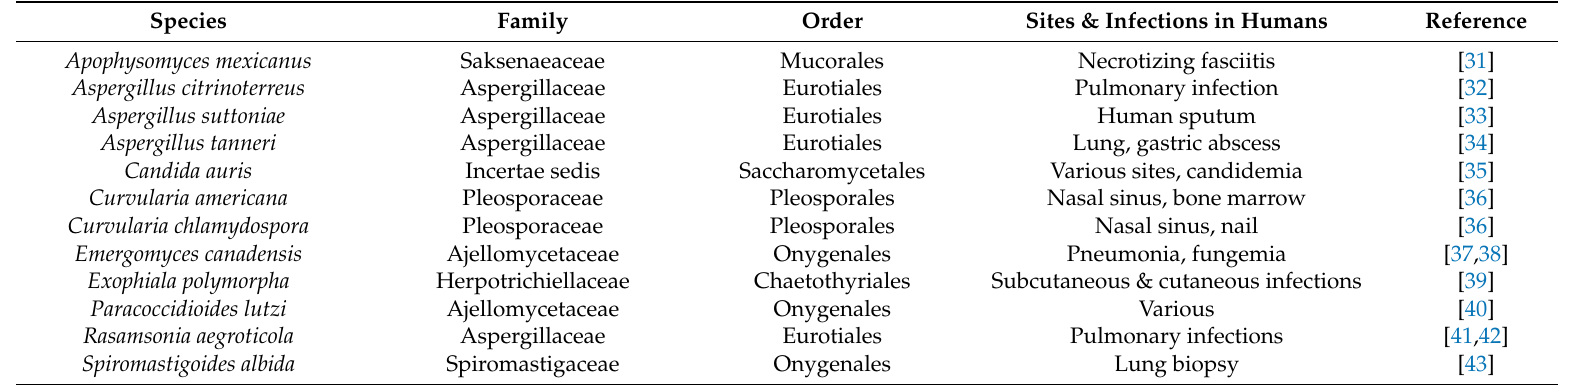
Table 1. Examples of recently described and medically relevant fungi.